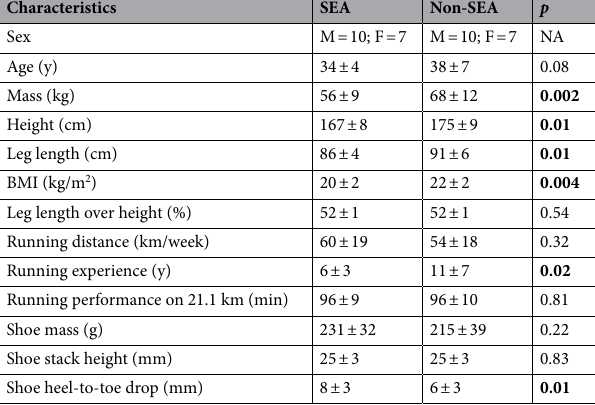
Table 1. Participant and footwear characteristics for South East Asian (SEA) and non-South East Asian (non- SEA) runners. Significant differences ( p ≤ 0.05) identified by Student’s or Welch’s t-tests are reported in bold. M male, F female, BMI body mass index, and NA not